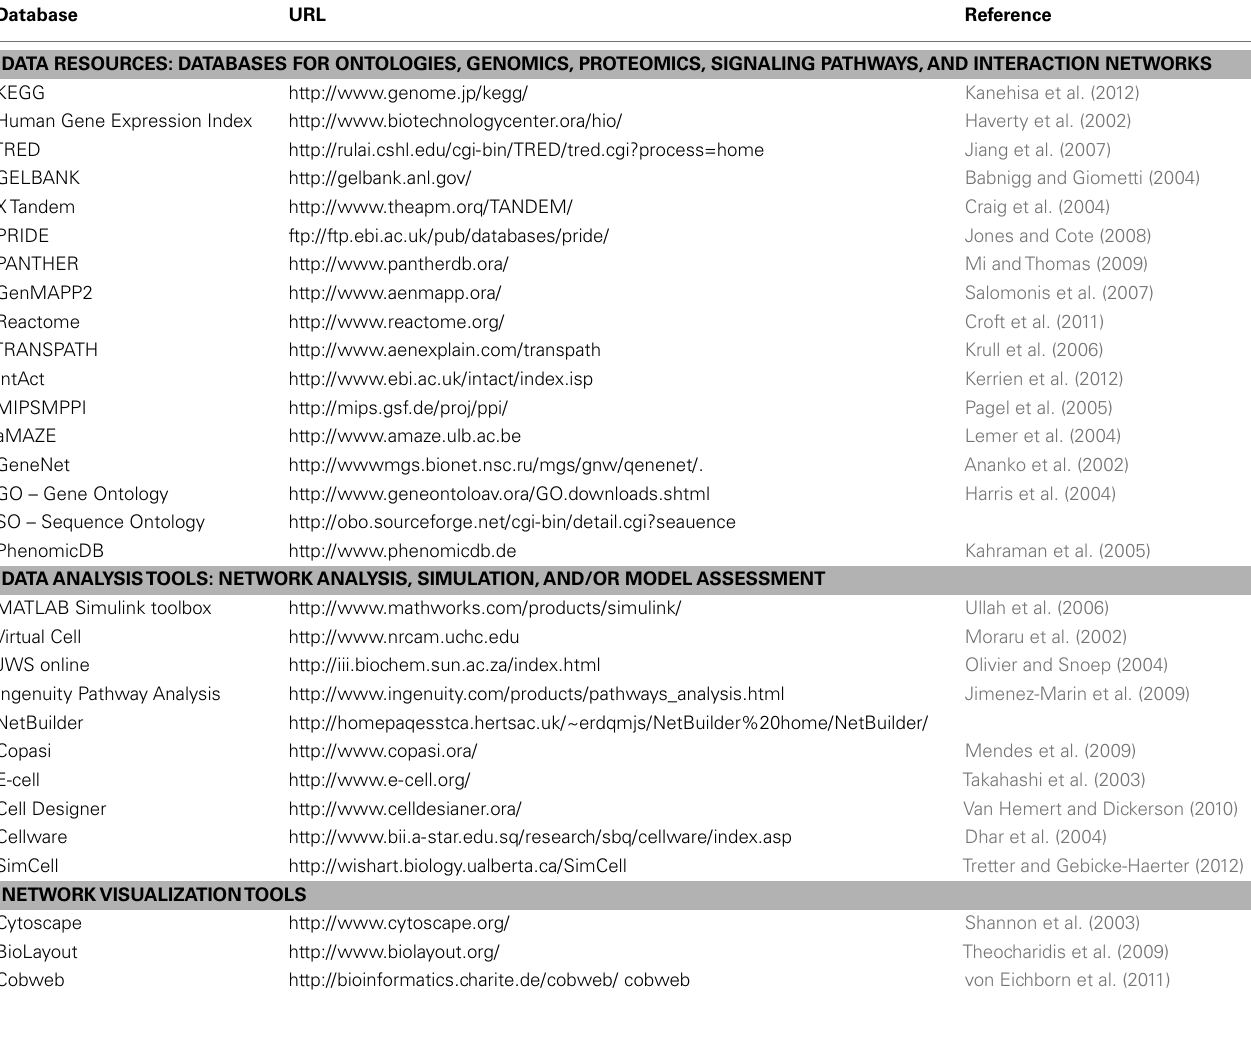
Table 1 | Examples of bioinformatic resources and computational